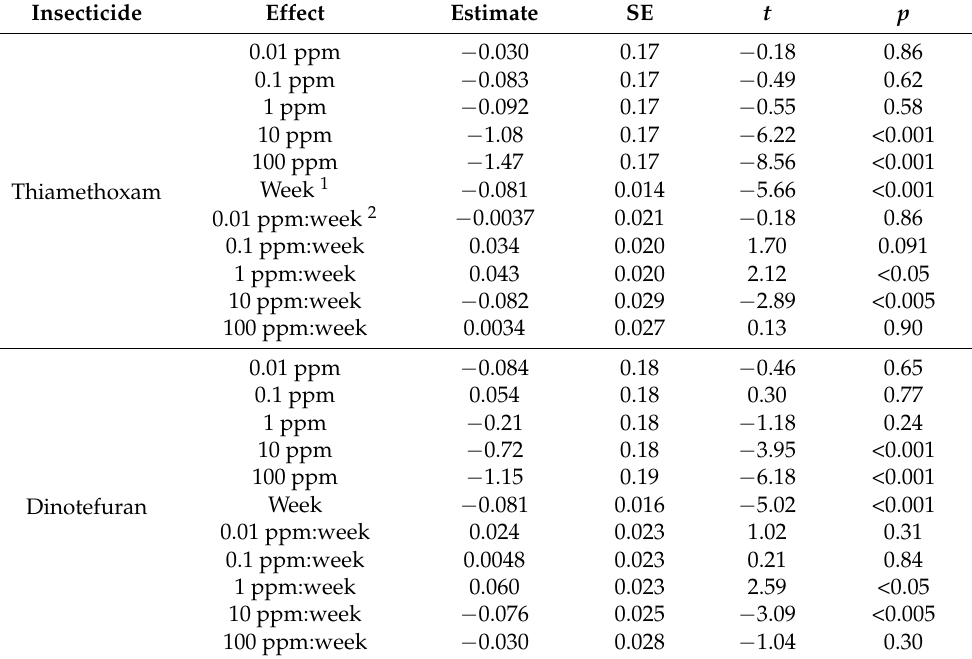
Table A5. Parameter estimates for GLMMs to explain the level of diet excavation by Aromia bungii late instar